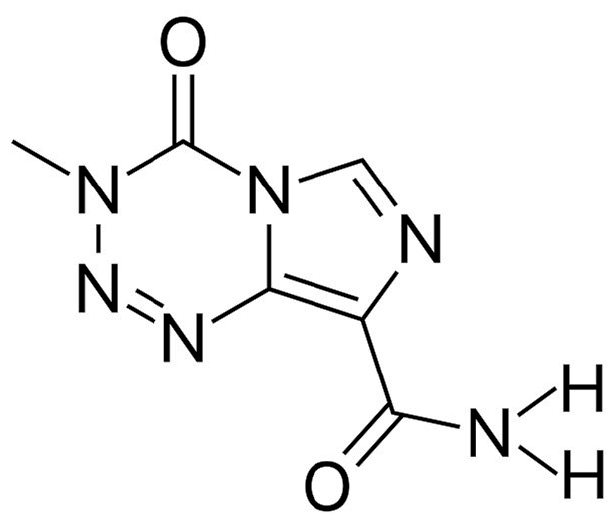
Figure 1. The chemical structure of temozolomide.